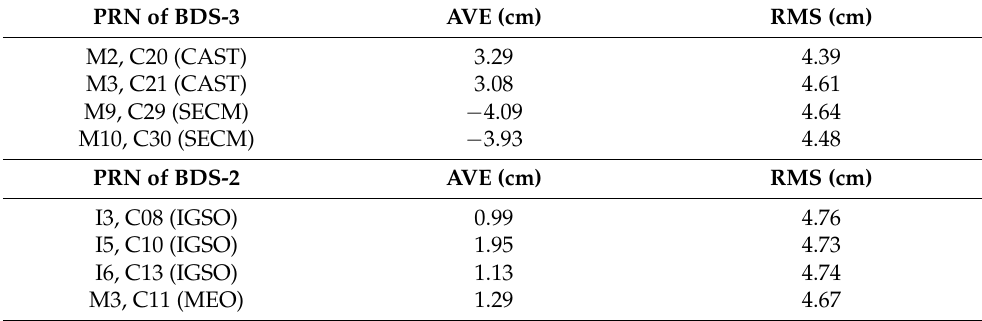
Table 9. Biases and mean RMS of SLR validation of BDS satellites.